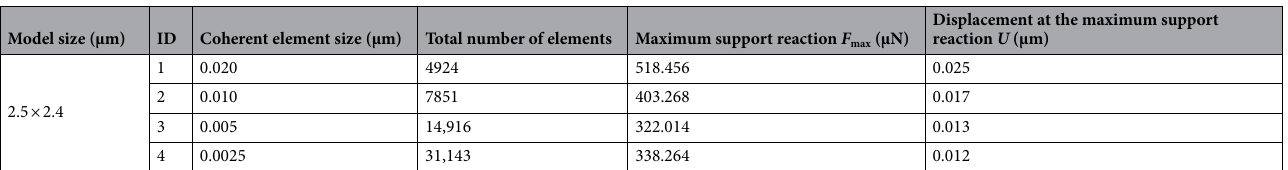
Table 11. length sensitivity analysis results of cohesive